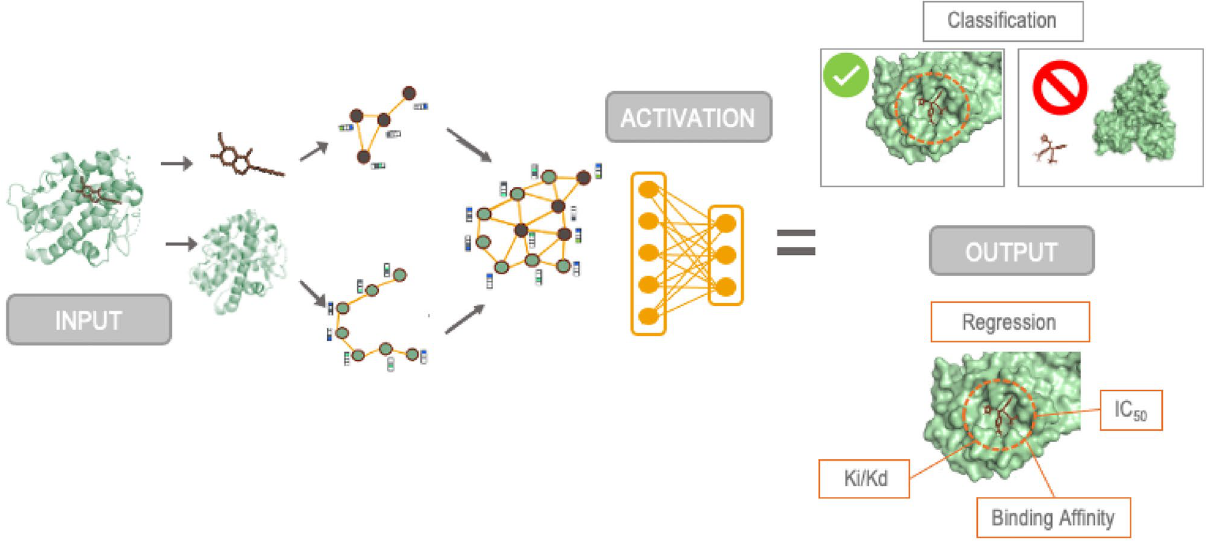
Figure 4. Schematic showing the results produced by each method in the both regression and classification model. The inclusion of 3D structural data provides numerous advantages and ability to produce such a range of prediction both activity and biophysical properties, their relationship with protein–ligand